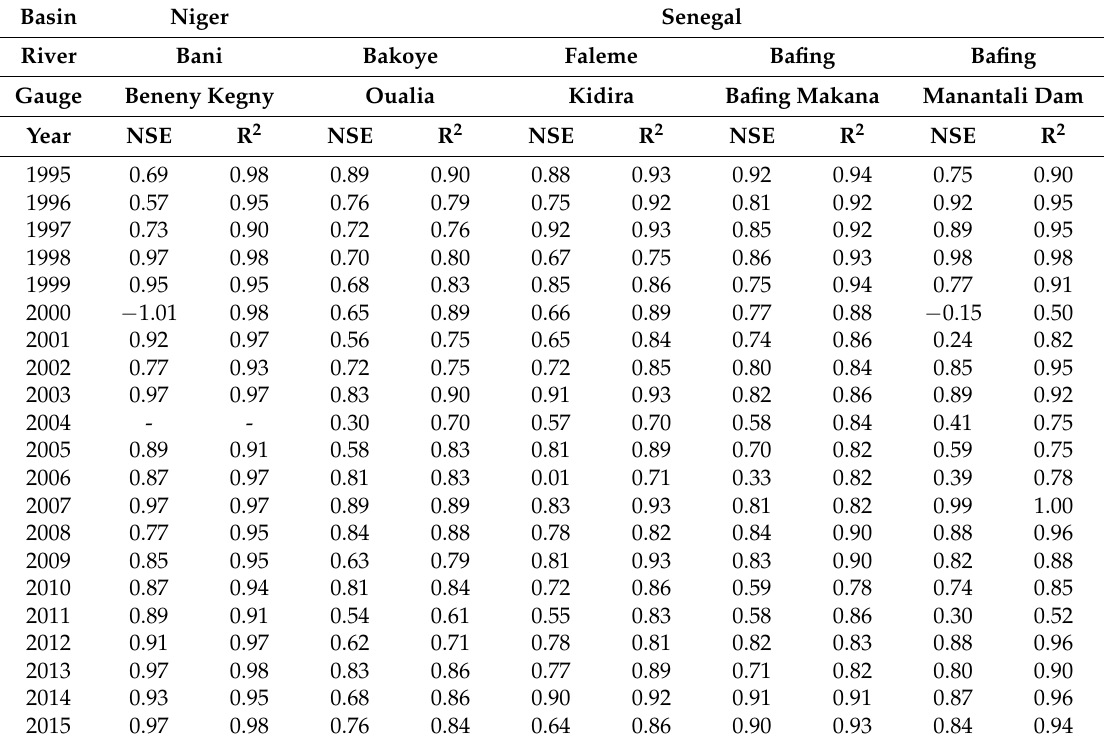
Table 6. Performance criteria of daily discharge simulations using bias-corrected PERSIANN-CDR. Basin Niger Senegal River Bani